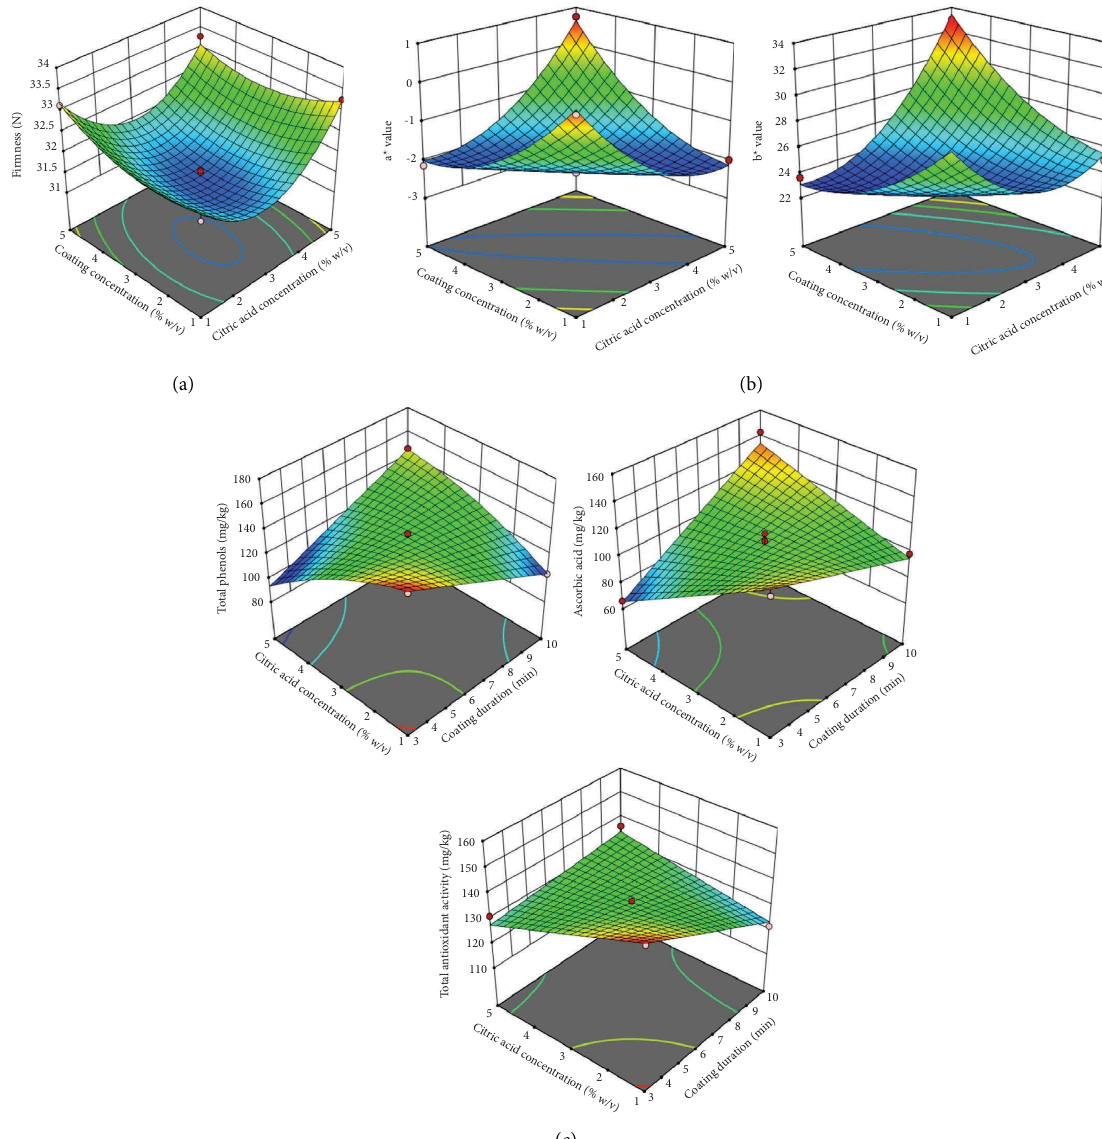
Figure 5: (a) Efect of coating concentration and citric acid concentration on frmness of eggplant fruit after 17d storage period at 10 ° C. (b) Efect of coating concentration and citric acid concentration on a ∗ and b ∗ values of eggplant fruit after 17d storage period at 10 ° C. (c) Efect of citric acid concentration and coating duration on total phenols, ascorbate levels antioxidant capacity of eggplant fruit after 17 d storage period at 10 °